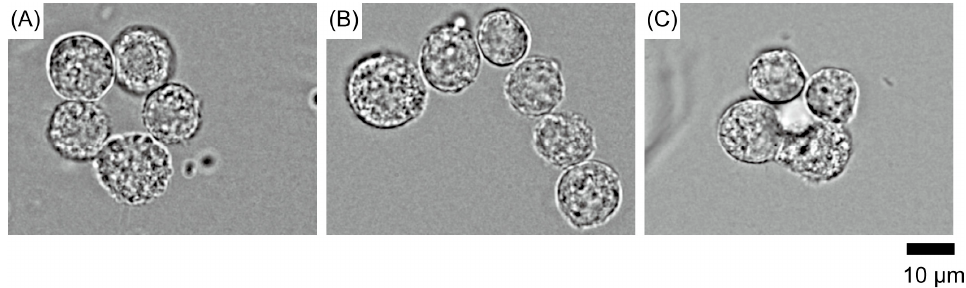
Figure 4. Assemblies of epithelial cells (NMuMG) of various shapes in a medium with DEX (40 mg/mL): the shape of a donut ( A ), letter ‘L’ ( B ), and tetragonal pyramid as an example of 3D cluster ( C ).